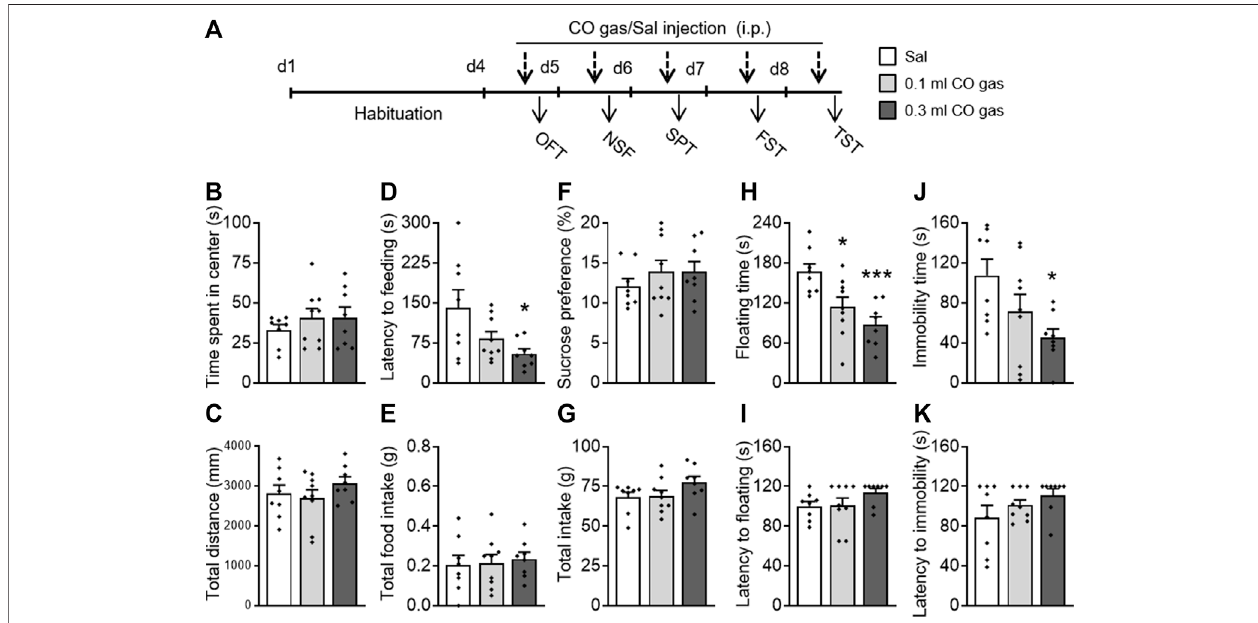
FIGURE 4 | Systemic CO gas administration exerted rapid antidepressant- and anxiolytic-like activities in mice. (A) After a 3-day-adaptation, each mouse was treated with saline (0.3 ml, i.p.) or CO gas (0.1, 0.3 ml, i.p.) daily 30 min prior to behavioral test. Time spent in central zone (B) and total distance traveled (C) had no effectswhentreatedwithCOgasintheOFT. IntheNSF test, latency tofeedingdecreased (D) but nottotalfood intake (E) . Noalteration occurredinsucrose preference (F) and in total intake (G) between three groups in the SPT. CO gas treatment decreased fl oating time (H) and immobility time (J) , but not fl oating latency (I) in the FST and the immobility latency (K) in the TST. The data are expressed as mean ± SEM and were analyzed with separate one-way ANOVAs. * p < 0.05, ** p < 0.01, *** p < 0.001 as compared to the saline-treated group. OFT, open fi eld test; NSF, novelty-suppressed feeding; SPT, sucrose preference test; FST, forced swimming test; TST, tail suspension test ( n (cid:2) 8 – 9 per